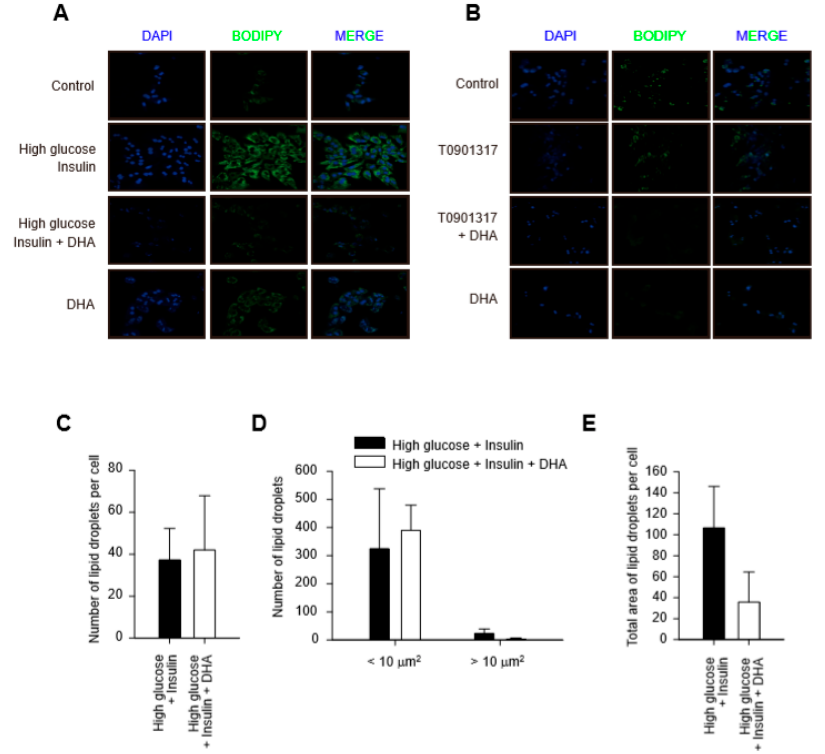
Figure 2. Morphological changes in lipid droplets (LD) after DHA treatment. ( A , B ) LD formation